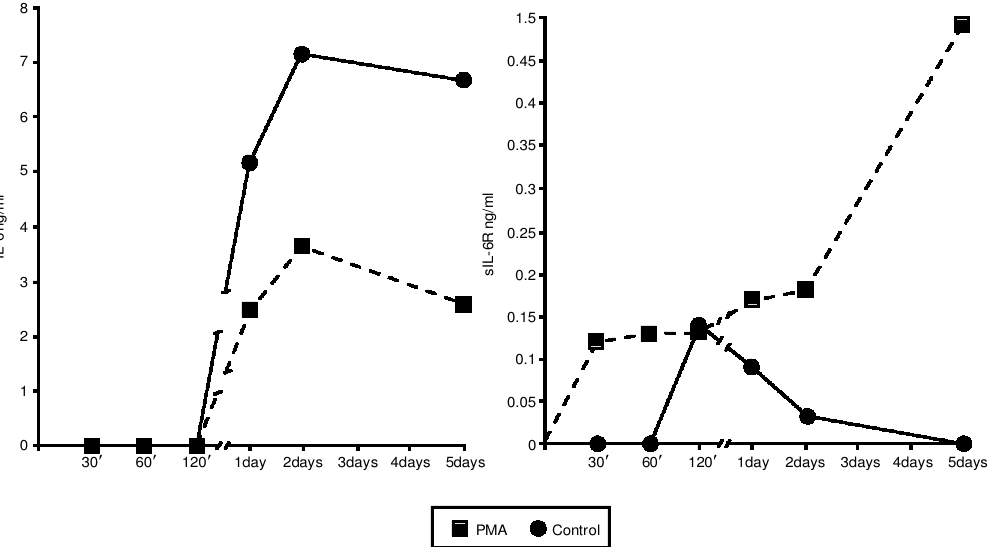
FIG. 3. A kinetic study of IL-6 and sIL-6R secretion from one case of B-CLL lymphocytes unstimulated or stimulated with PMA (10 m